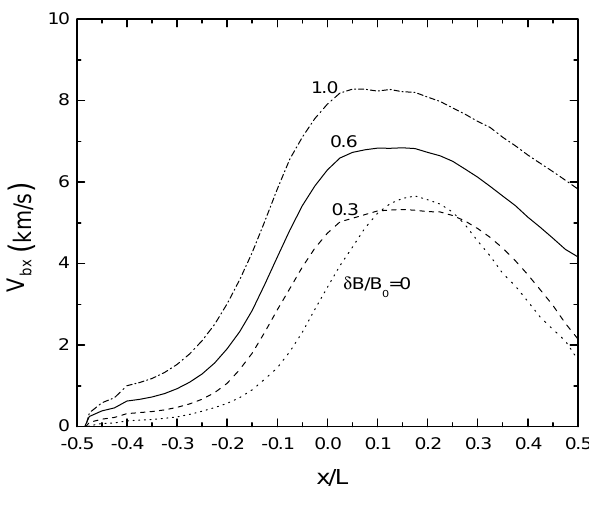
Fig. 6. Oxygen density profile for different turbulence levels (as indicated). Dimensionless units.